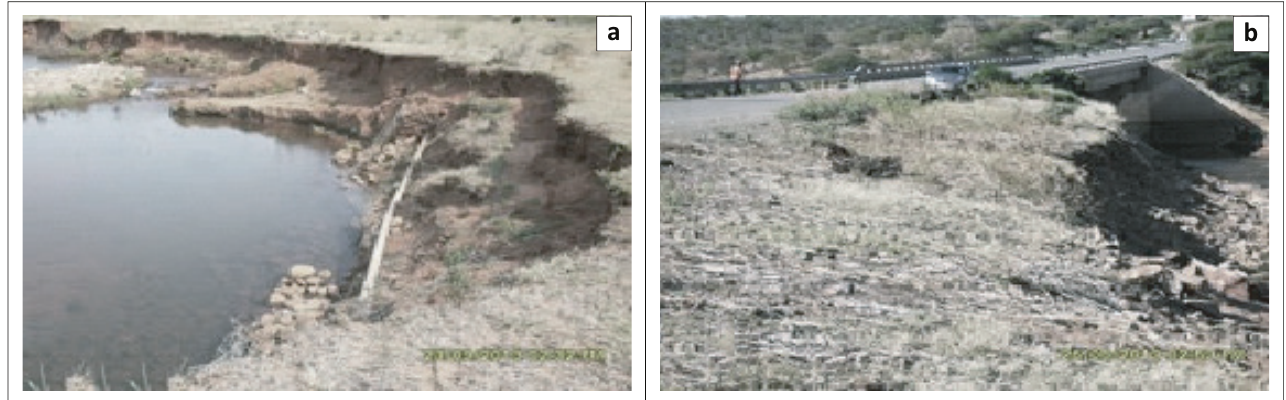
FIGURE 3: Exposed water line (a) and bridge foundation (b).